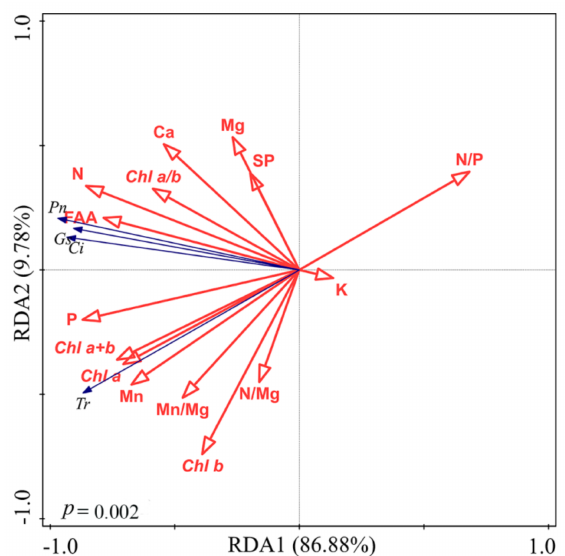
Figure 3. Redundancy analysis (RDA) of photosynthetic parameters and N metabolites, and foliar nutrient status. The angle and length of the arrows indicate the respective direction and strength of the relationship of the photosynthetic parameters and N metabolites, and foliar nutrient status. Abbreviations: SP, Soluble protein; FAA, Free amino